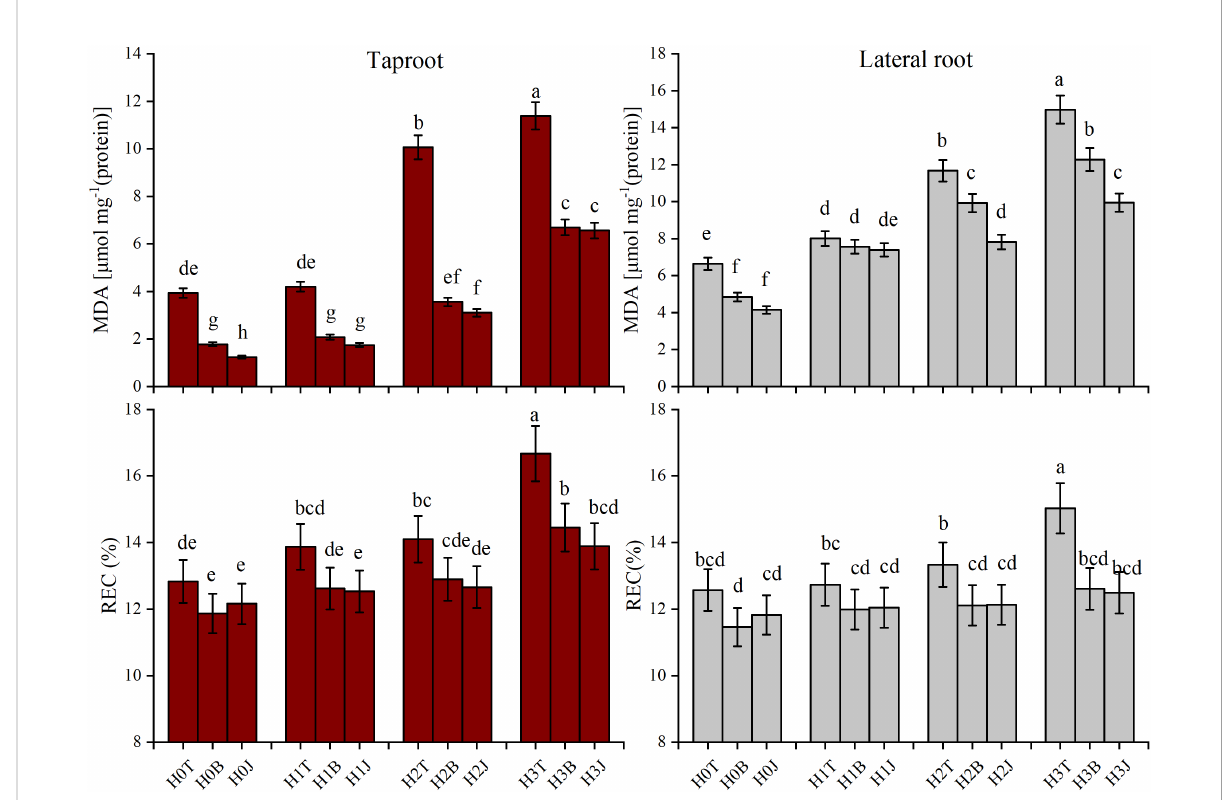
FIGURE 3 Effect of biochar and biofertilizer applications on cotton root malondialdehyde (MDA) and electrolyte leakage rate (REC). Values are means ± SE (n=5). Different lowercase letters indicate signi fi cant differences at P < 0.05 (the Duncan